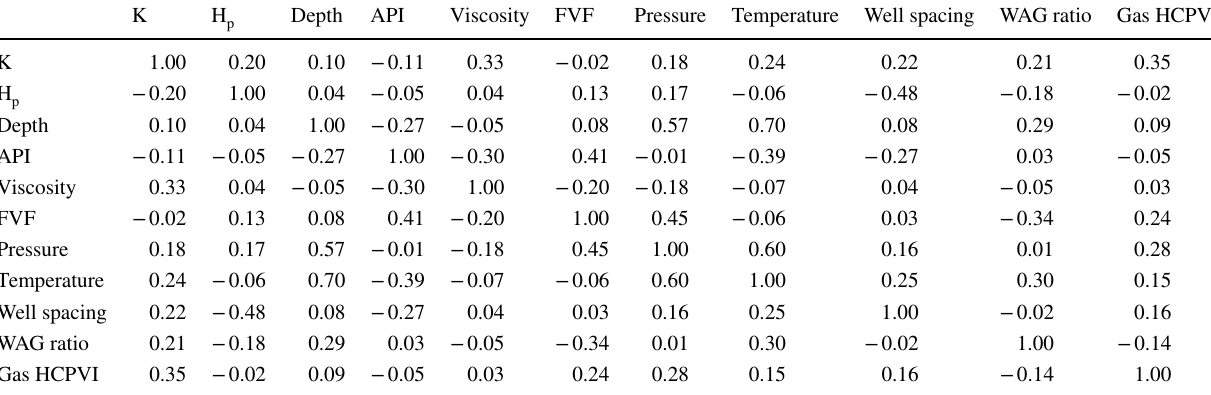
Table 2 WAG pilot input vectors Pearson’s correlation